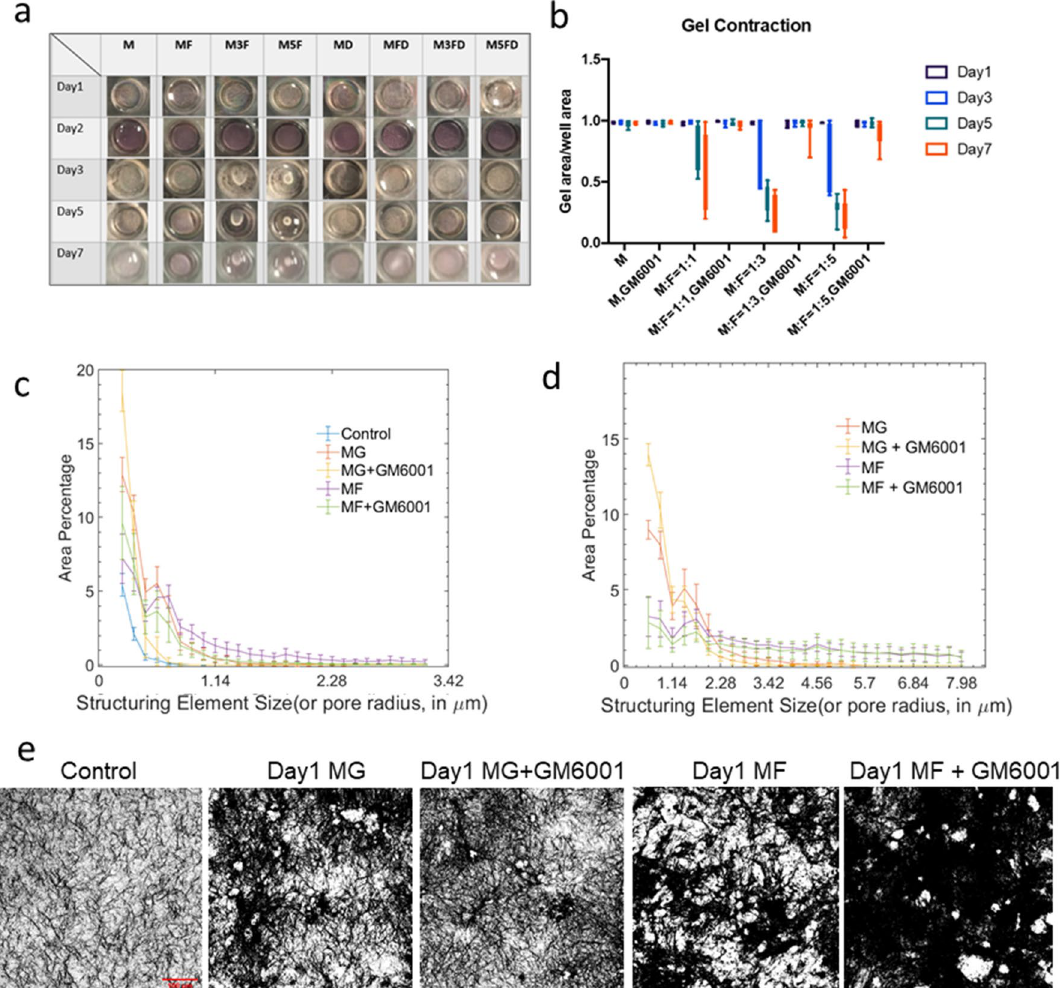
Figure 6. Quantification of global and local changes in collagen scaffold. ( a ) Gel compaction recorded longitudinally from day1 to day7."M" indicates MDA-MB-231 monoculture, "MF" indicates initial seeding concentration between MDA-MB-231 to NHLF is 1:1; "M3F" indicates initial seeding concentration between MDA-MB-231 to NHLF is 1:3; "M5F" indicates the initial seeding concentration between MDA-MB-231 to NHLF is 1:5; "MD" indicates MDA-MB-231 monoculture with 20µM GM6001 treatment; "MFD" indicates an initial seeding concentration ratio of 1:1 between MDA-MB-231 to NHLF with 20µM GM6001 treatment; "M3FD" indicates an initial seeding concentration ratio of 1:3 between MDA-MB-231 to NHLF with 20µM GM6001 treatment; "M5FD" indicates an initial seeding concentration ratio of 1:5 between MDA-MB-231 to NHLF with 20µM GM6001 treatment. ( b ) Quantification of gel compaction. The ratio indicates an initial seeding concentration between MDA to NHLF in each condition. Data from at least triplicates are averaged, and in each repeat there are duplicate wells for each condition. Error bars in SEM. ( c ) and ( d ) Pore size distribution on day 0 ( c ) and day 1 ( d ). Around 5–12 images (around 1000×1000 pixels) from two replicates were used for the quantification. The existence of NHLF contributes to the erosion of collagen scaffold and lead to larger hole size overall. GM6001 inhibits ECM erosion and breakage, consistent with the global gel compaction trend. ( e ) Binarized collagen images before pore size measurement. Similar to control conditions, day1 MDA monoculture generally has more small pores visually than coculture conditions, consistent with quantification shown in ( d